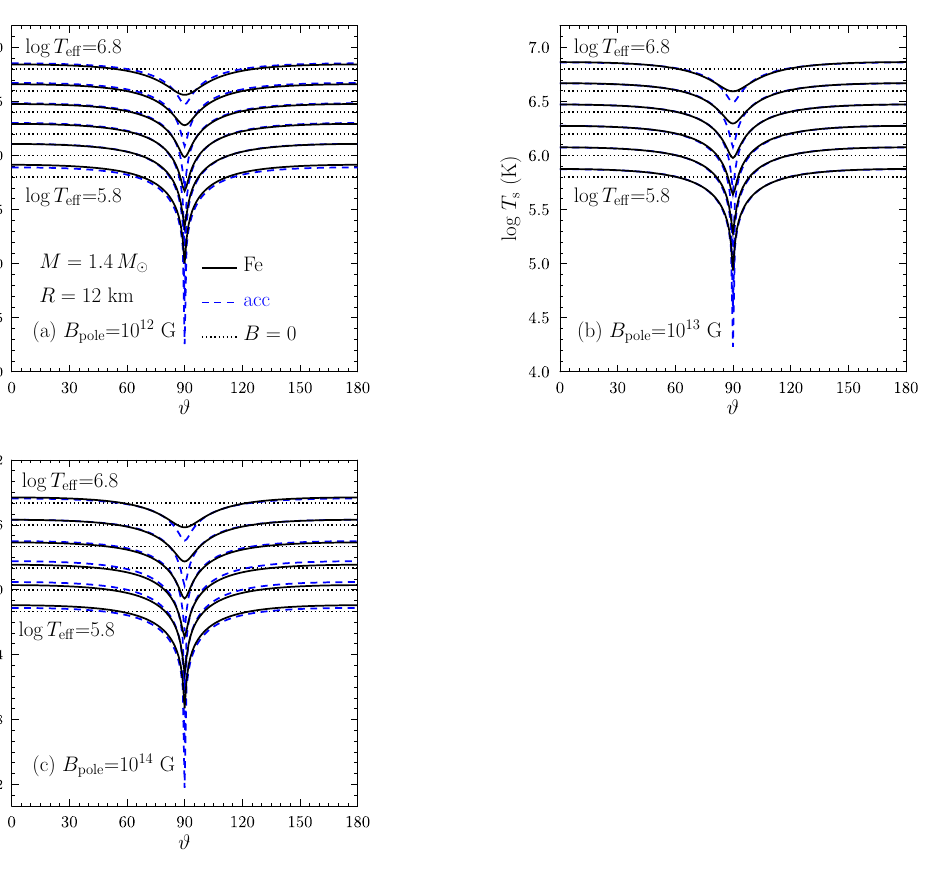
Figure 2. Effective surface temperature T s versus colatitude ϑ , from magnetic pole ( ϑ = 0) to equator ( ϑ = 90 ◦ ) and the opposite magnetic pole ( ϑ = 180 ◦ ) of a neutron star with M = 1.4 M R = 12 km at three values of B pole = 10 12 , 10 13 and 10 14 G [panels ( a – c )]. The curves are plotted for six effective surface temperatures, log T eff [K] = 5.8, 6.0 ...6.8. Solid curves refer to the heat-blanket model made of iron, dashed cures refer to the heat blanket of fully accreted matter; dotted curves correspond to the field-free